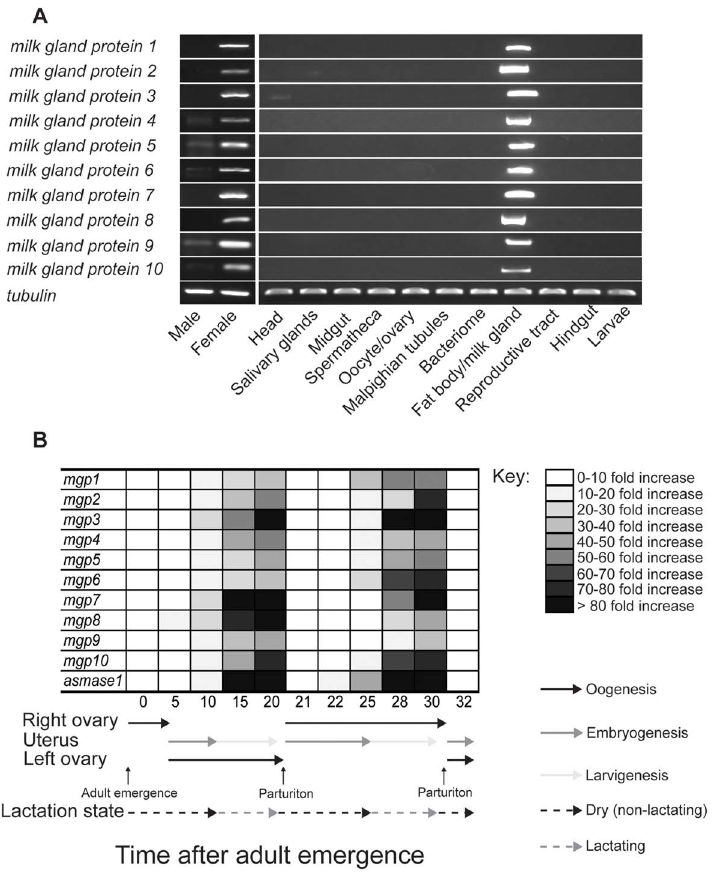
Figure 9. Temporal and spatial expression of milk gland protein genes. (A) Tissue specific RT-PCR. Data represents three replicates. ( B) Time course of mgp1–10 and asmase1 expression during the first two tsetse gonotrophic cycles. Transcript levels were determined by qPCR using a CFX PCR detection system (Bio-Rad, Hercules) and data were analyzed with CFX manager software version 3.1 (Bio-Rad). Data represents the mean 6 SE of three replicates and was normalized to tubulin .